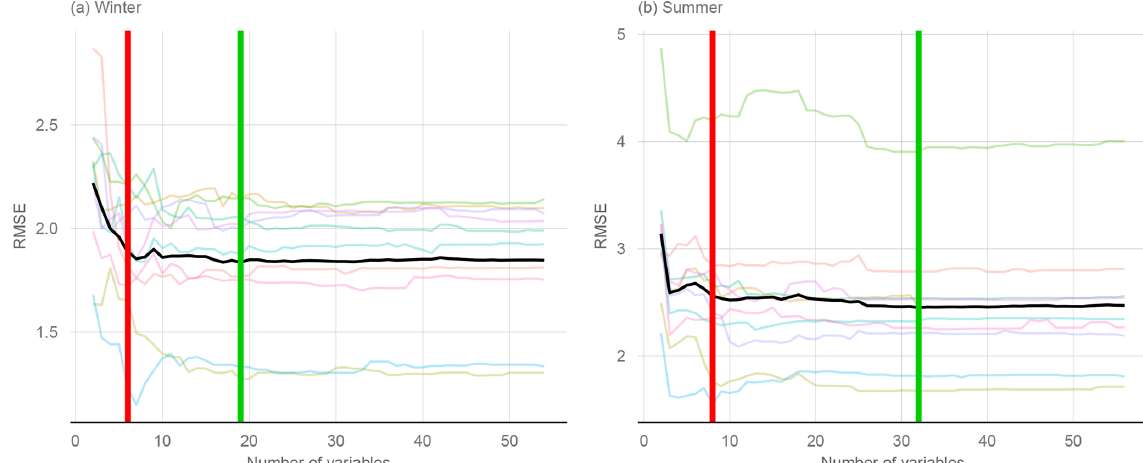
Figure 4. Variable selection for a GAM boosting model based on RMSE graphs. The red vertical line indicates the number of variables selected by a 5% increase in the min ( RMSE ) , and the green line is the number of variables obtained by min ( RMSE ) . The black graph is the average over 10 inner CV folds, and colored graphs represent individual folds.